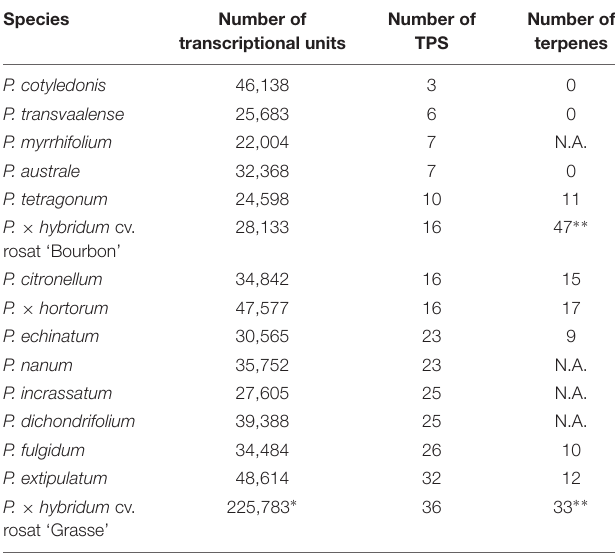
TABLE 2 | Number of assembled transcripts, number of TPS sequences and number of detected compounds amongst a common set of terpenes between